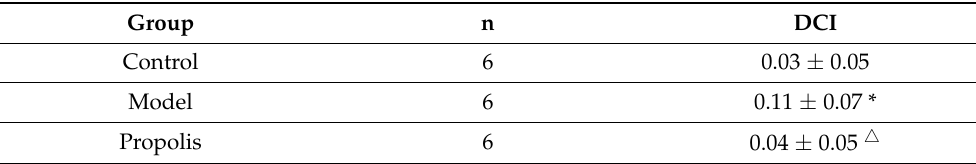
Figure 3. Effects of propolis on alcohol-induced hippocampal injury, BDNF and serum monoamine expression in mice. ( A ) The morphological structure of the hippocampal CA3 region. ( a , a’ ) control group; ( b , b’ ) model group; and ( c , c’ ) propolis group, Scale bars = 200 µm. ( B ) Levels of serum BDNF of the mice in the different groups. ( C ) Levels of serum DA of the mice in the different groups. ( D ) Levels of serum 5-HT of the mice in the different groups. * Denotes p < 0.05 vs. control group; △ p < 0.05 vs. model group. Table 1. The analysis of denatured cell index (DCI) in HE staining. * Denotes p < 0.05 vs. control group; (cid:52) p < 0.05 vs. model